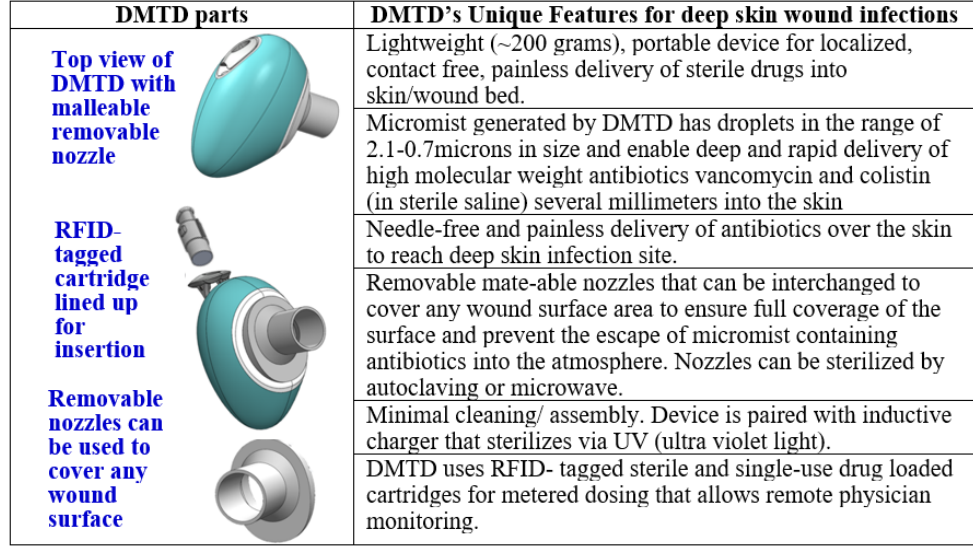
Figure 1. Unique characteristics of DMTD that allows localized transdermal delivery of high molecular weight antibiotics to treat deep skin infections and avoid systemic adverse side effects.